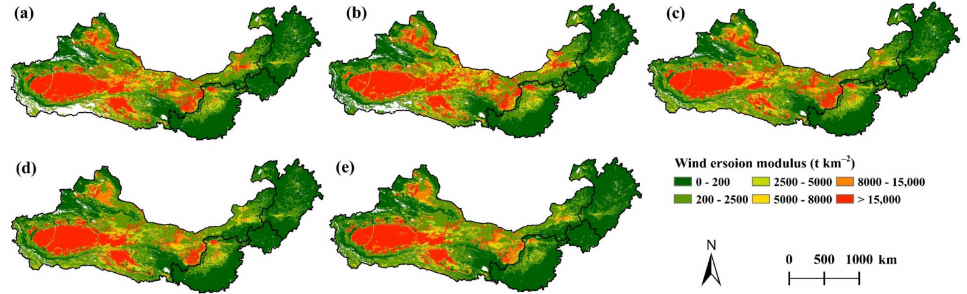
Figure 3. Spatial pattern of the mean wind erosion modulus in the TNR of China from 1981 to 2020. ( a ) 1981–2020; ( b ) 1981–1990; ( c ) 1991–2000; ( d ) 2001–2010; ( e )